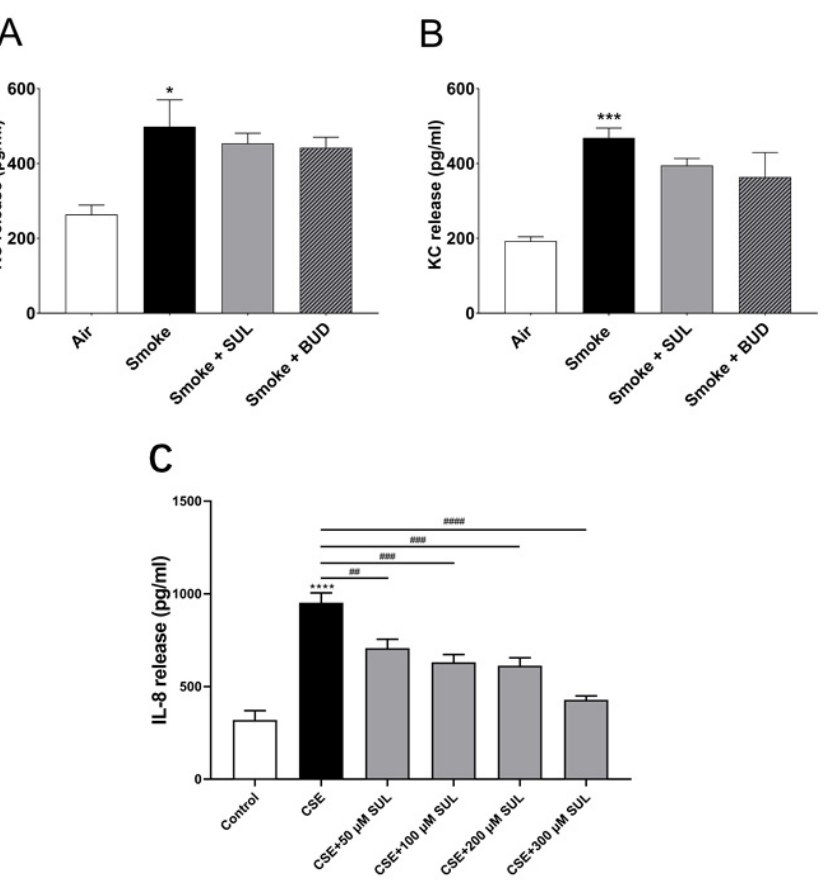
Figure 7. SUL-151 hardly affects KC levels in lung homogenates but concentration-dependently inhibits IL-8 production in human bronchial epithelial cells. Mice were exposed to CS for 5 days (twice/day) and received SUL-151 or budesonide via oropharyngeal administration 30 min before the first-time smoke exposure during these 5 days ( A ) or mice were exposed to CS for 10 days (twice/day) and received SUL-151 or budesonide via oropharyngeal administration (once/day) 30 min before the first smoke exposure during the last 5 days of the CS period ( B ). KC levels were measured in the lung homogenates via ELISA measurement. Human bronchial epithelial cells (16HBE cells), grown on 96-well plates, were preincubated with different concentrations of SUL-151 (50, 100, 200, and 300 µ M) (24h) prior to CSE exposure for 24 h. Thereafter, IL-8 secretion was measured in the supernatants ( C ). Values are expressed as mean ± SEM. * p < 0.05, *** p < 0.001, **** p < 0.0001, smoke/CSE group compared to air/control group; ## p < 0.01, ### p < 0.001, #### p < 0.0001, CSE group compared to the CSE + SUL group. n = 4–8 mice/group in vivo, n = 5,in vitro.